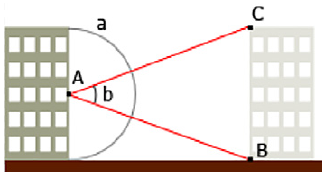
Figure 4. Vertical view angle, where: a – zone of interest that represents full view angle in 180 degrees; b – representation of the view angle for the object; AB and AC – baseline and topline of the object